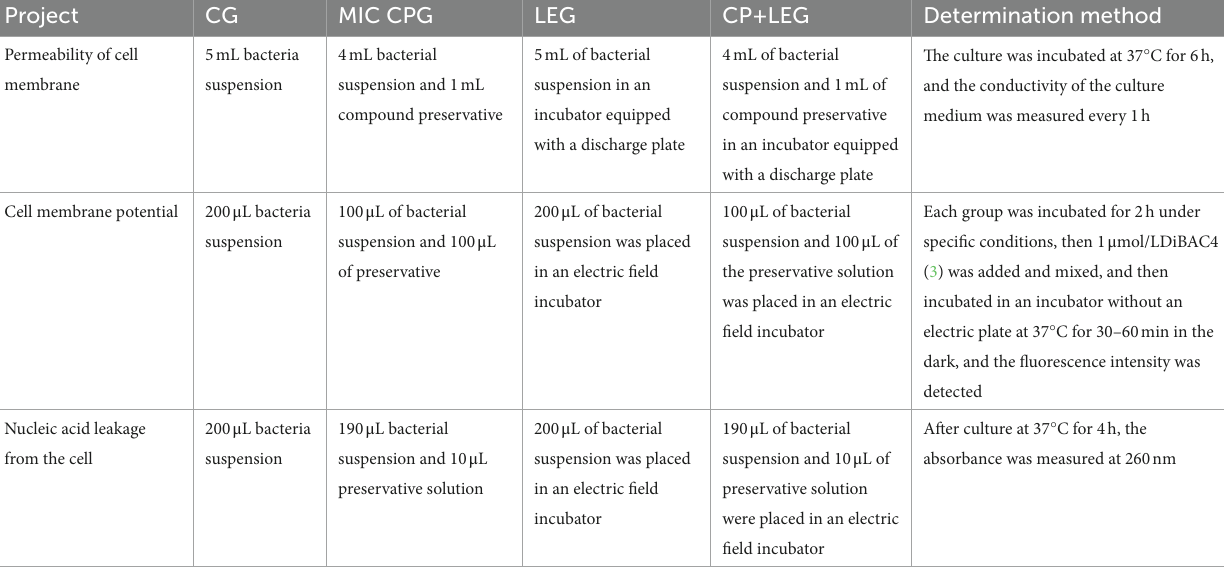
TABLE 2 Somatic cell membrane-related experiments.